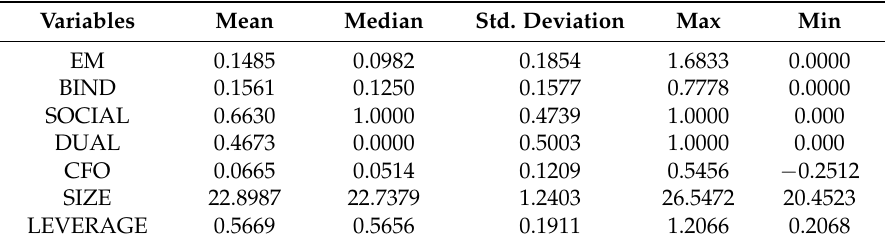
Table 2. Descriptive